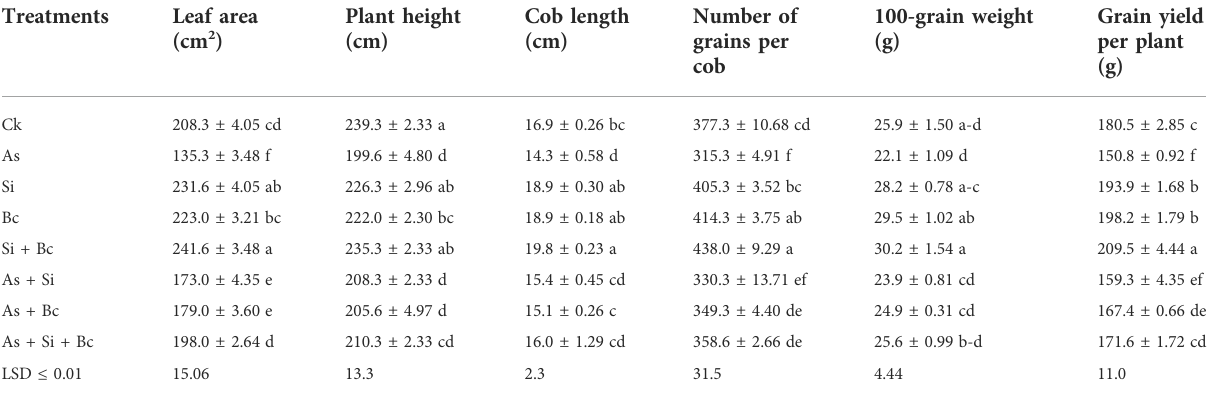
TABLE2EffectofsoleandcombinedapplicationsofSiandbiochar(Bc)onleafarea,plantheight,coblength,numberofgrains,100-grainweight,and grain yield of maize under As toxicity (values are the average of three replication ± standard error).